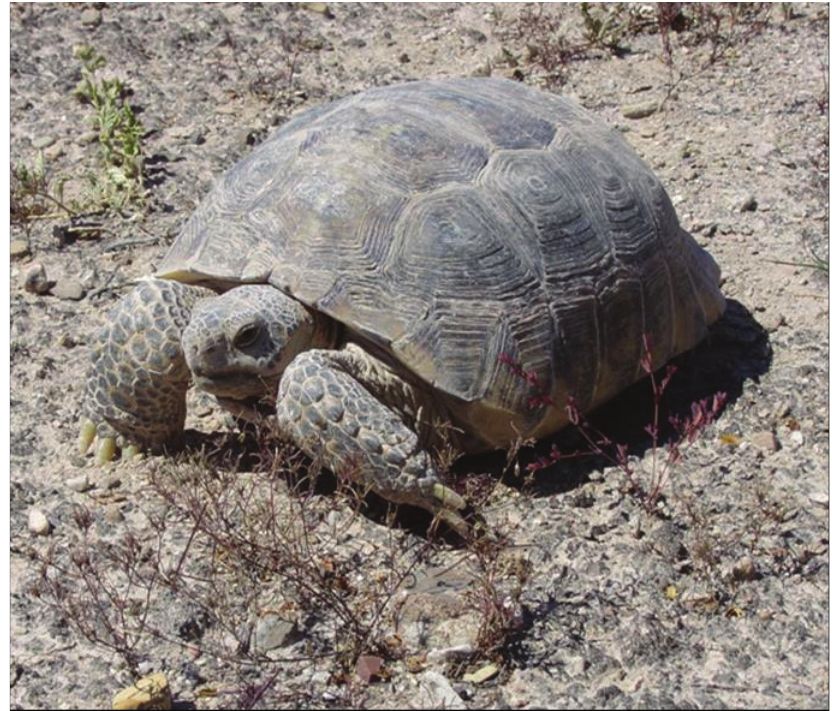
Figure 1. Gopherus flavomarginatus (Bolson